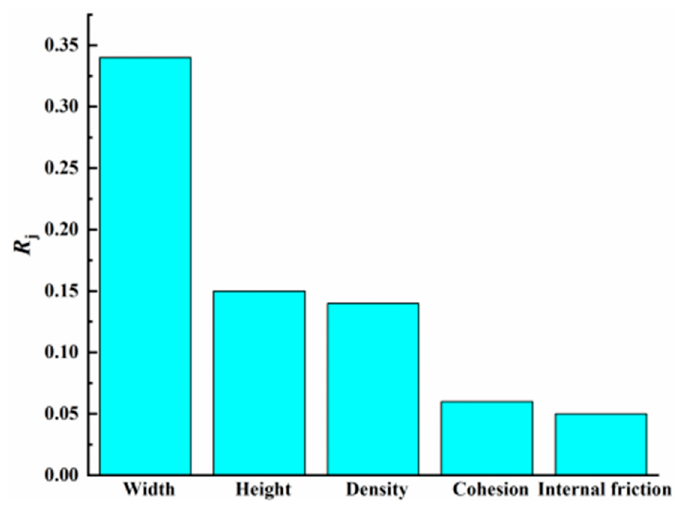
Figure 11. The range for every factor.